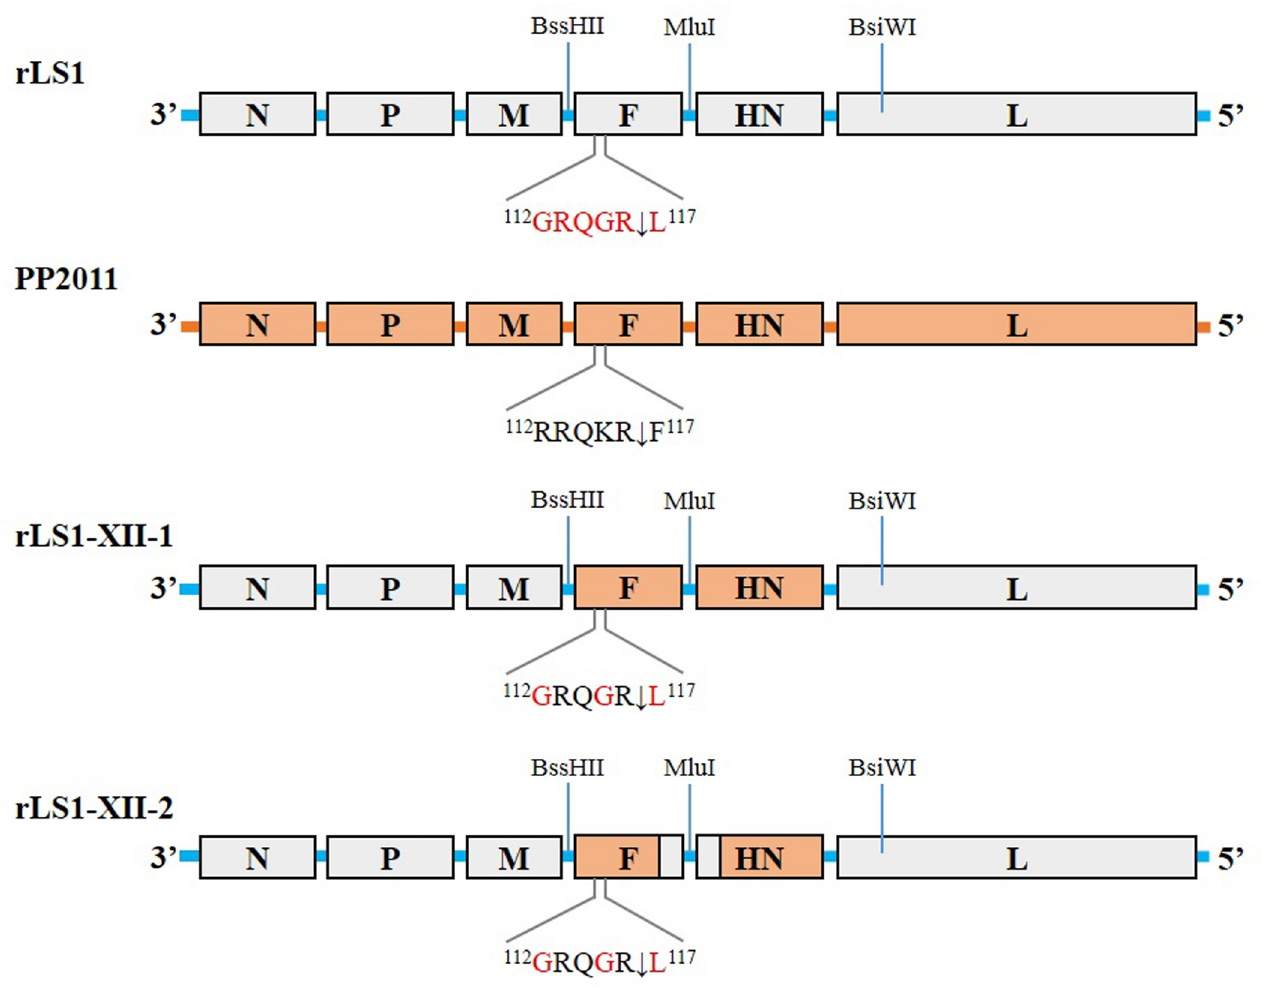
Fig 1. Viral gene maps. The gene map at the top is the parental NDV strain rLS1 and it shows the three unique restriction sites used for swapping F and HN gene ORFs. The next map illustrates the wild-type strain PP2011 (genotype XII). The last two maps are of the two chimeric derivative viruses. The rLS1-XII-1 has the complete F and HN ORFs swapped by those of the PP2011 strain, whereas rLS1-XII-2 has the cytoplasmic tails restored to those of the original rLS1 strain. The F protein cleavage sites are shown.